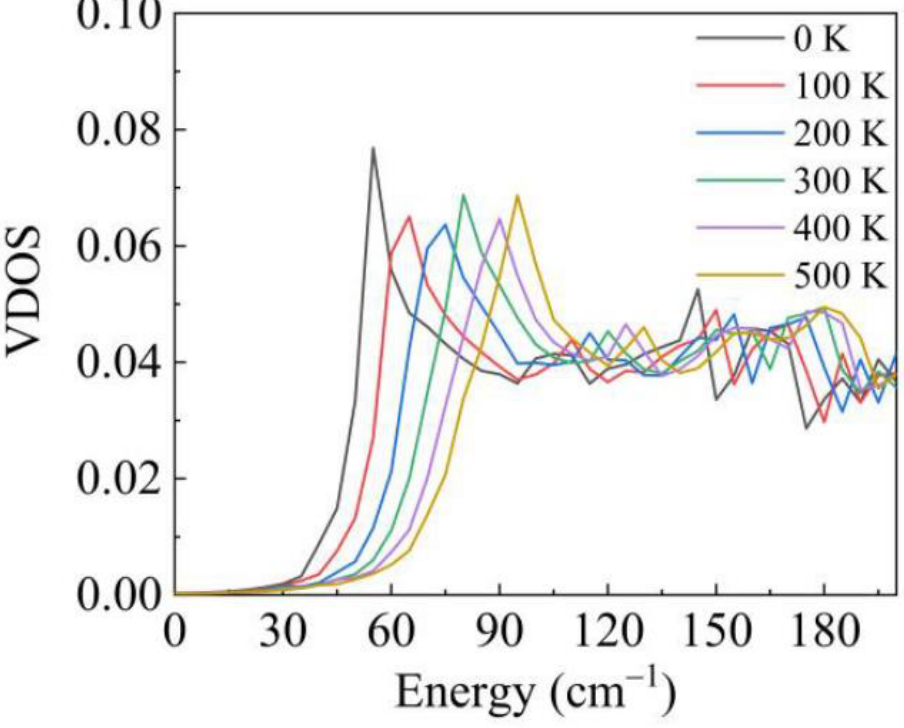
Figure 2. Considering quartic anharmonic, VDOS of α -Cristobalite with different temperatures at the low-frequency region.